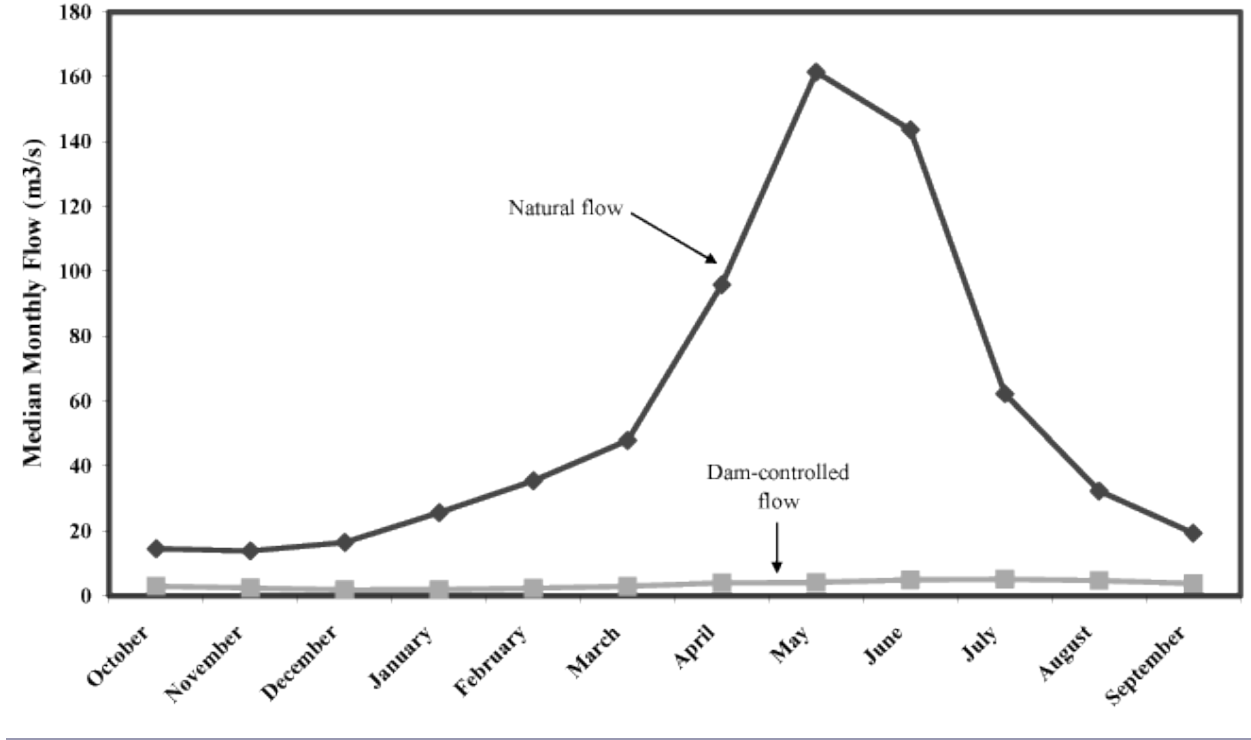
Fig. 3. Operation of an irrigation supply dam on the San Joaquin River in California, USA has severely depleted river